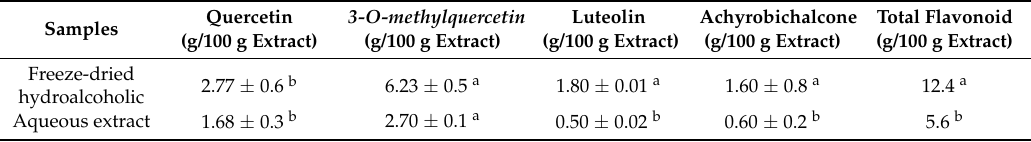
Table 1. Total flavonoids content of Achyroclines satureoides (AS) extracts ( µ g · mg − 1 DW).